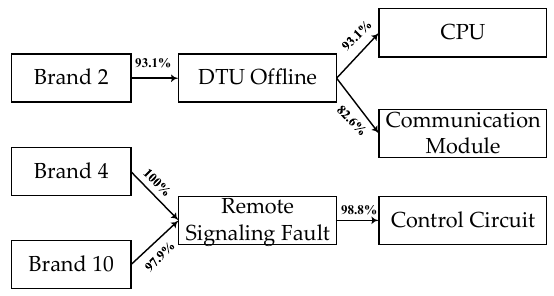
Figure 7. Strong rules including brand information.